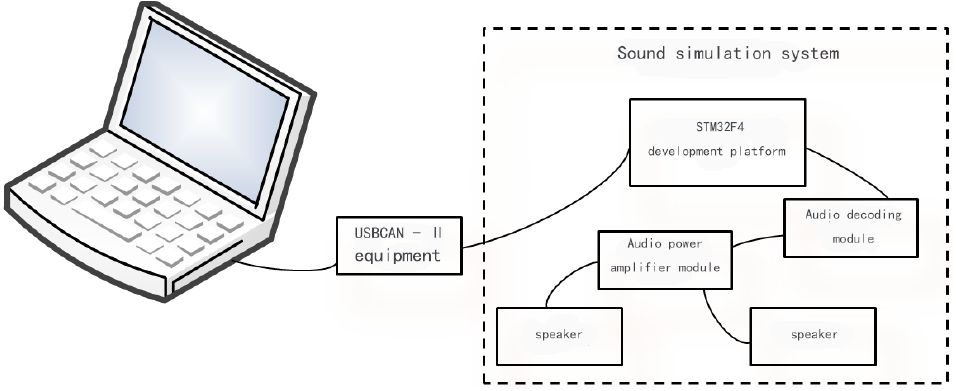
Figure 22. Connection relationship of the test platform of a sound simulation system.